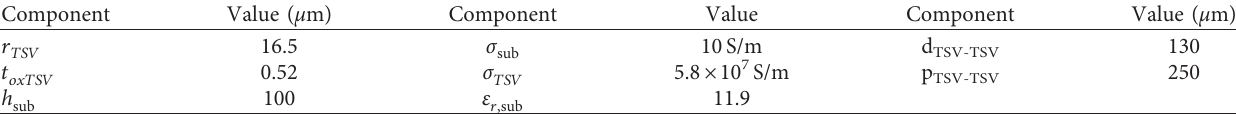
Table 1: Physical dimensions and material properties of the test vehicle.